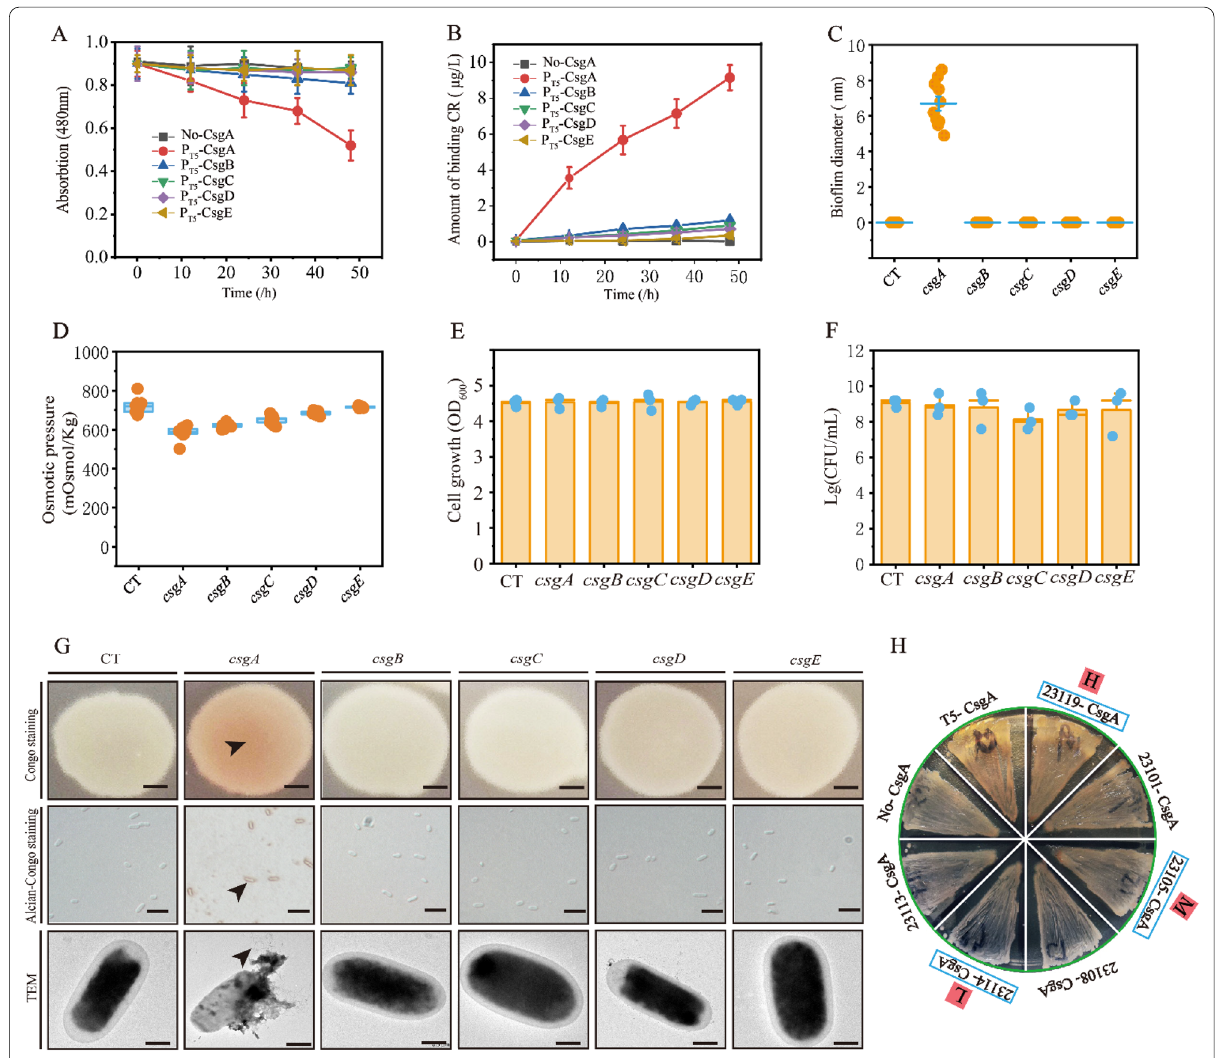
Fig. 1 Characterization of E. coli biofilm synthesis by genetic manipulation. A The absorption of congo red with different biofilm genes in E. coli MG1655. B Comparing the amount of binding congo red with different biofilm genes in E. coli 1655. C Comparing the biofilm diameter